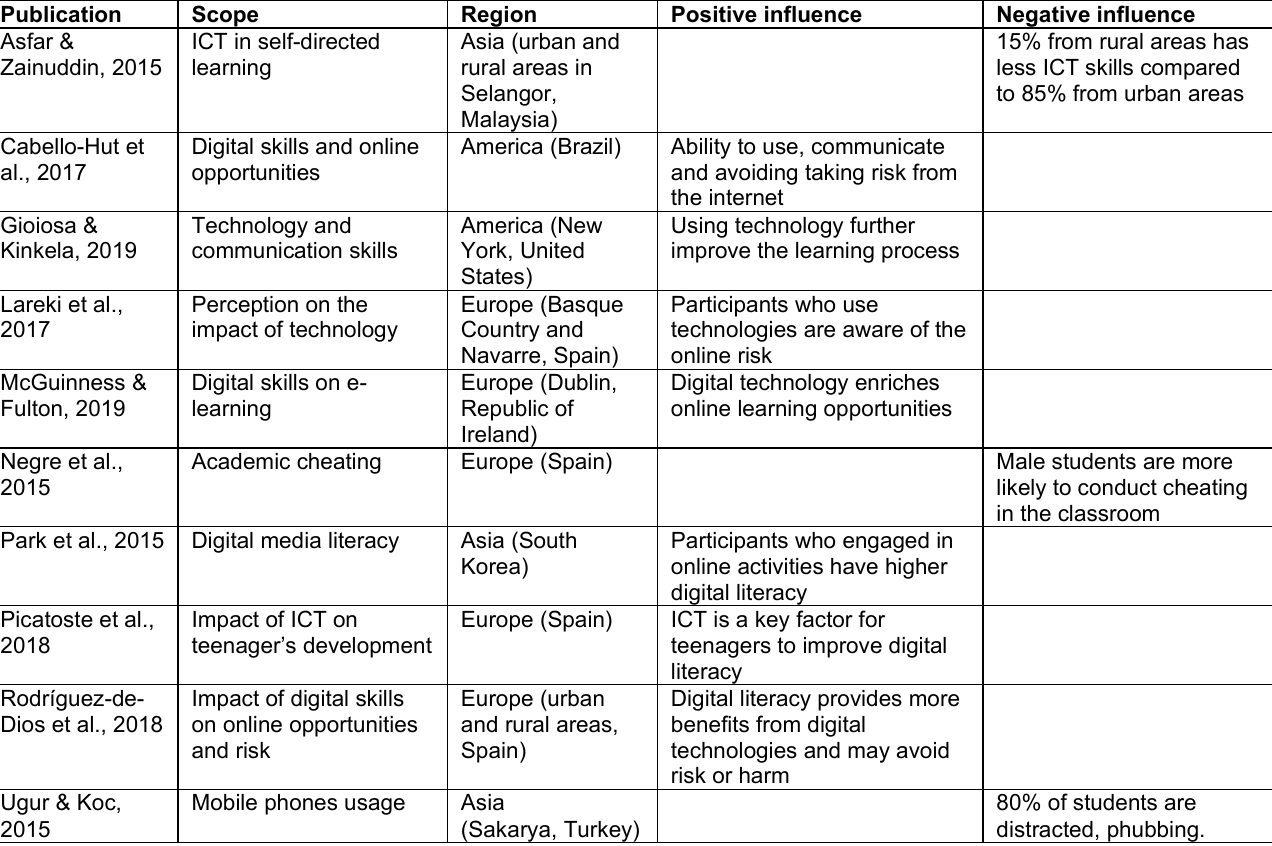
Table 1. Studies on the influence of ICT on